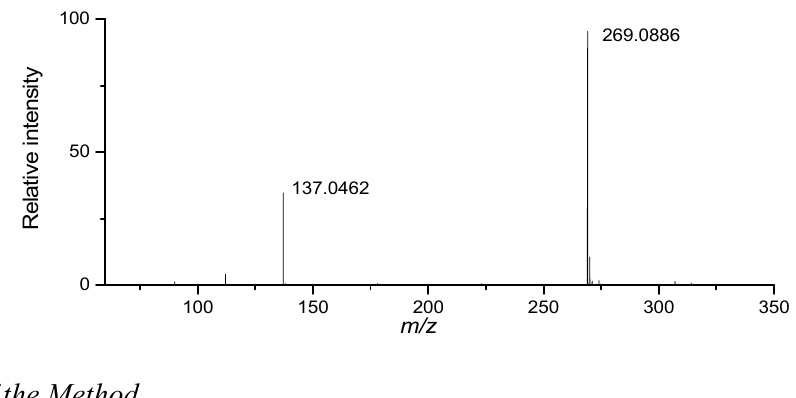
Figure 3. MS spectrum of peak 11.